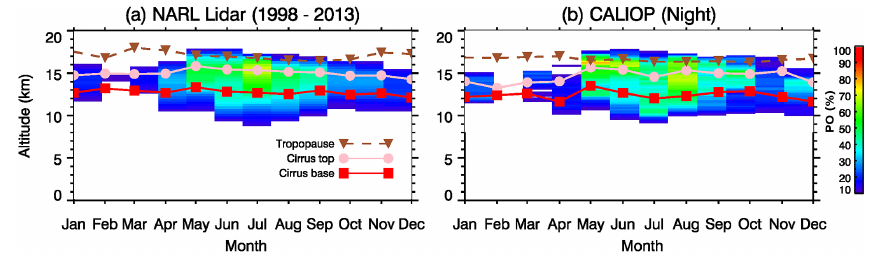
Figure 3. Filled contours show the climatological monthly mean variation of PO of cirrus clouds as a function of altitude over Gadanki (a) during 1998–2013 using NARL Lidar, (b) during 2006–2013 using CALIOP (night-time) data. Monthly mean tropopause height, cloud base height and cloud top height are shown by dashed brown lines with inverted triangles, red line with squares and pink line with filled circles,